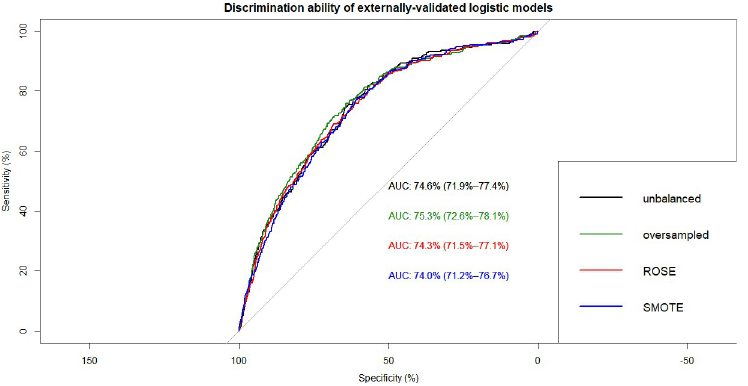
Fig 3. Overlapped ROC curves demonstrating predictive performance of logistic regression models on external validation data. Using unbalanced, original training data and re-structured with oversampling, ROSE and SMOTE